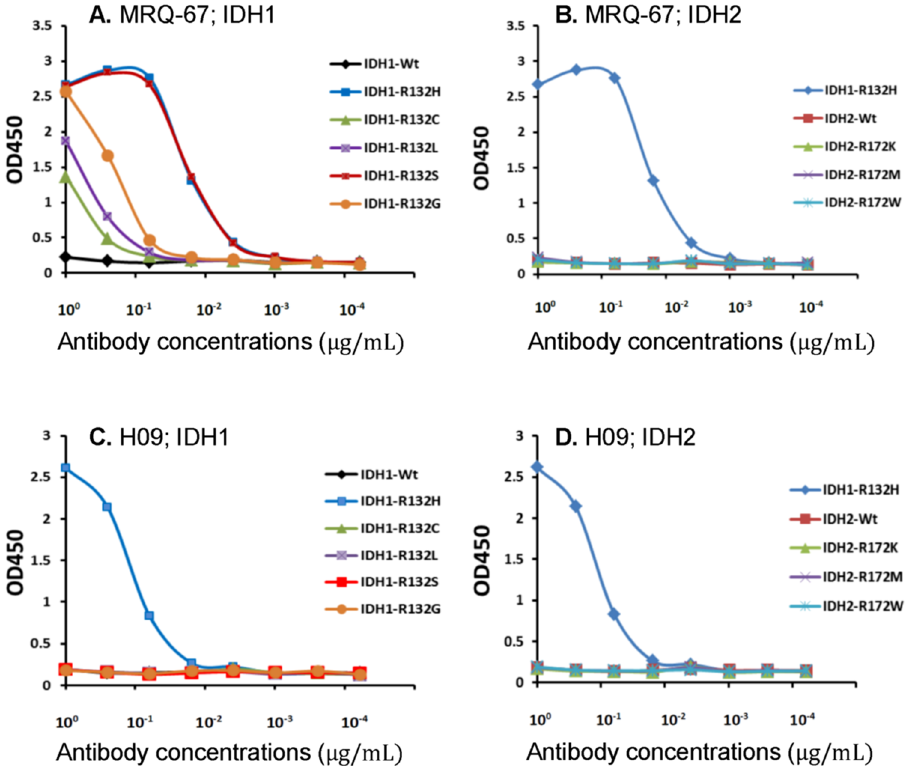
Figure 1. Liquid-phase binding of the antibodies MRQ-67 ( A , B ) and H09 ( C , D ) to wild-type (wt) and mutant IDH1 ( A , C ) and IDH2 peptides ( B , D ), as measured by ELISA and expressed as optical densities at 450 nm